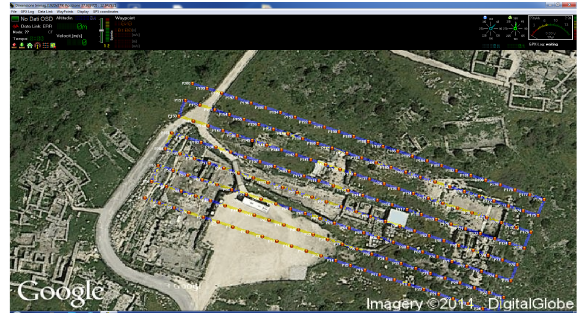
Figure 3. Flight plan for the aerial photogrammetry